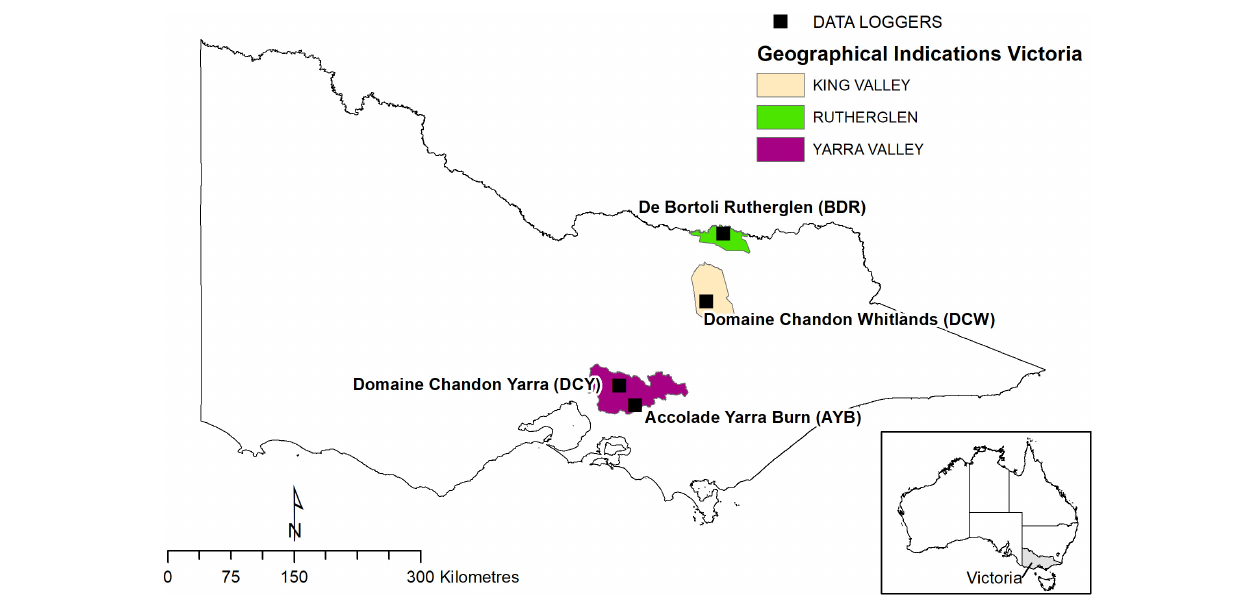
FIGURE 1 | Map with location of vineyards